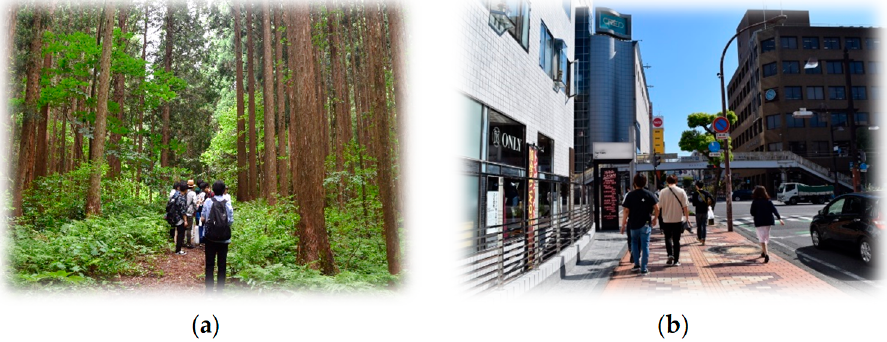
Figure 1. Pictures of the forest walk ( a ) and urban walk ( b ).